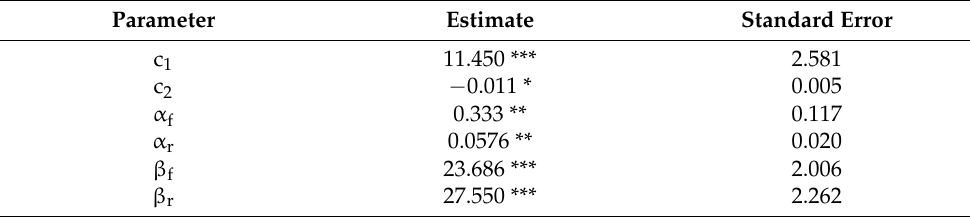
Table 1. Ecosystem Production (EP) model